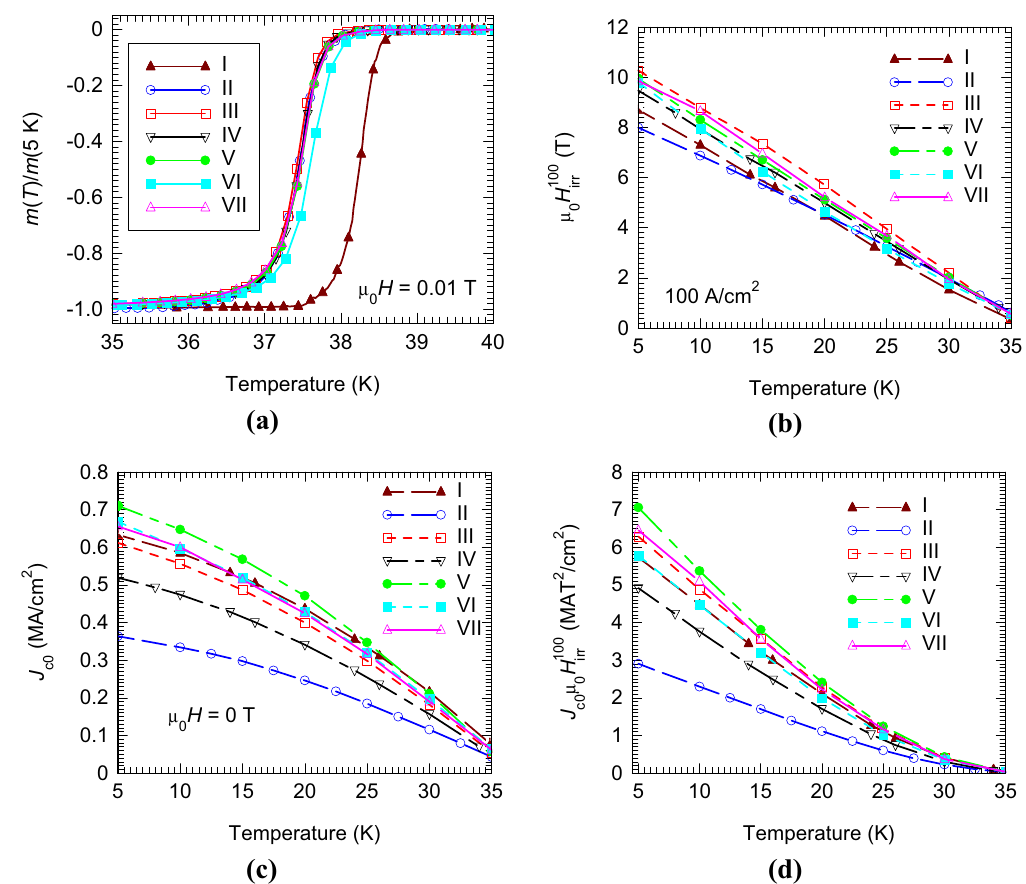
Figure 4. Temperature dependence of the reduced magnetization versus temperature measured in zero-field- cooling arrangement at 0.01 T ( a ), irreversibility field µ 0 H irr ( b ), zero-field critical current density J c0 ( c ), and the product ( J c0 × μ 0 H irr ) for pristine and added samples II–VII ( d ).